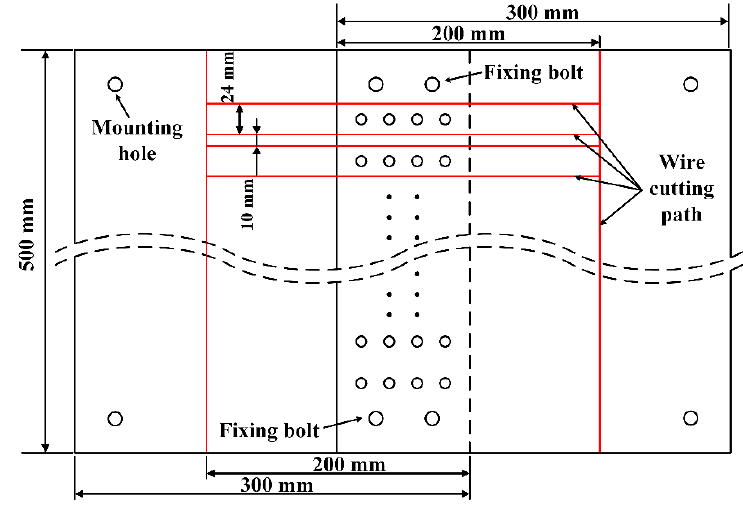
Figure 14. The riveted lap joint specimen to be processed.